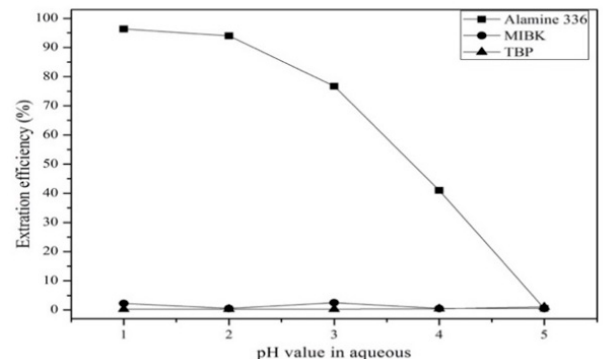
Figure 8. Effect of different extractants on the tantalum extraction efficiency. Concentration: 0.01 mol/L. Extraction time: 5 min. A/O = 1.